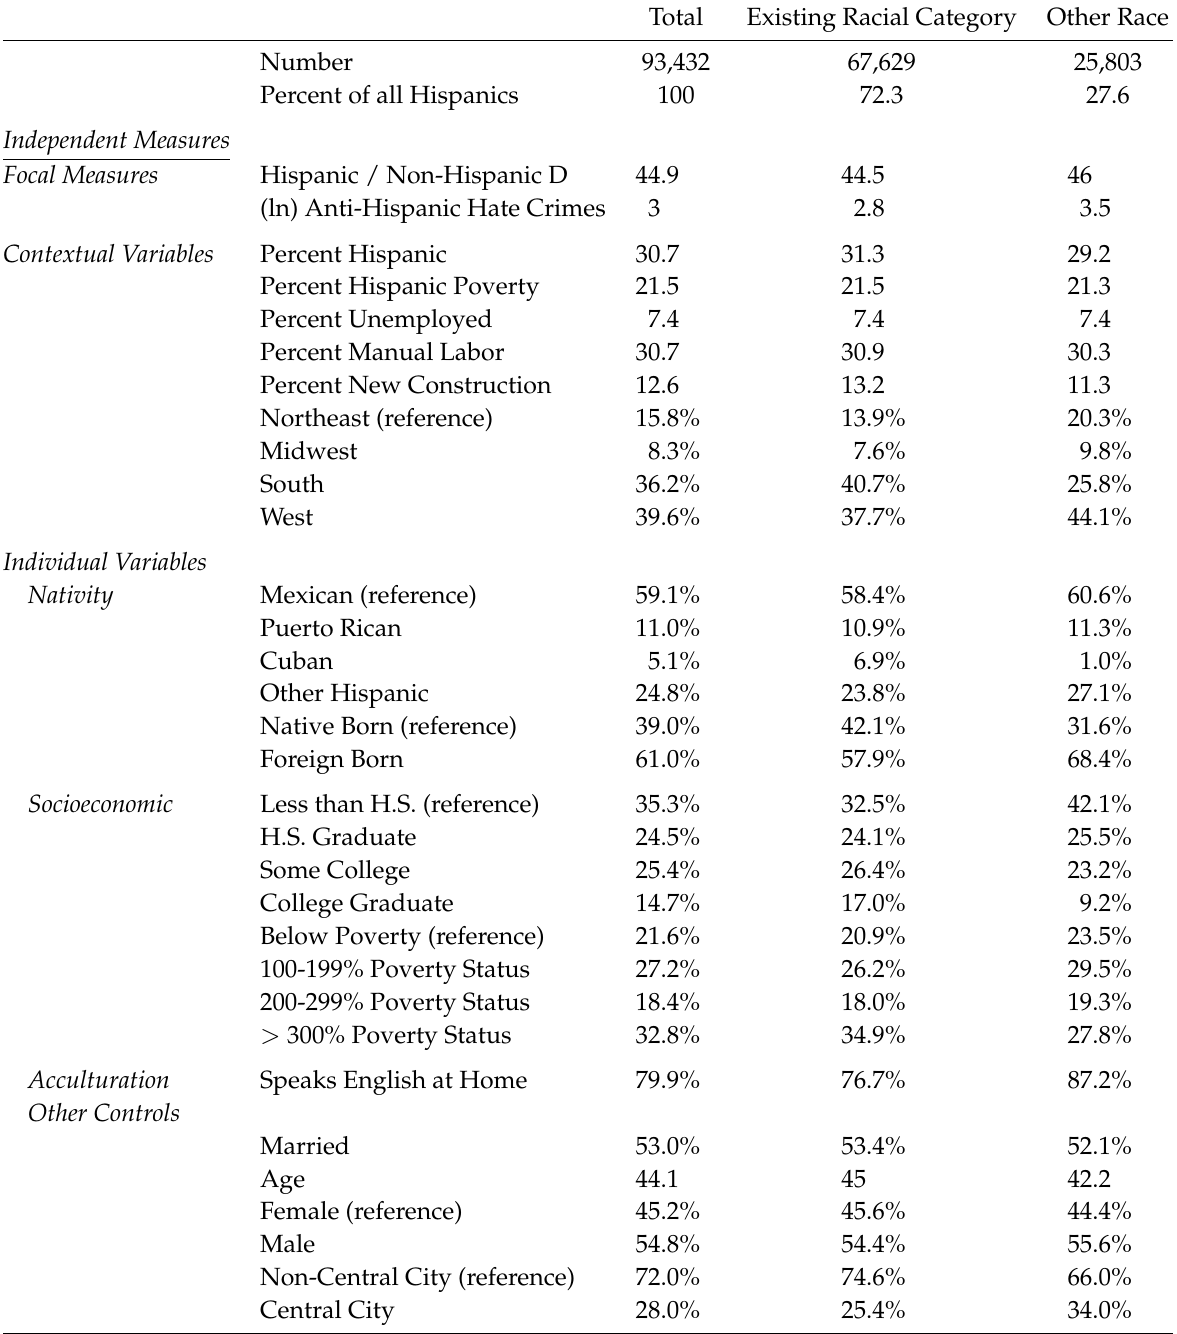
Table 1: Descriptive Statistics of Hispanic Racial Identification, American Community Survey